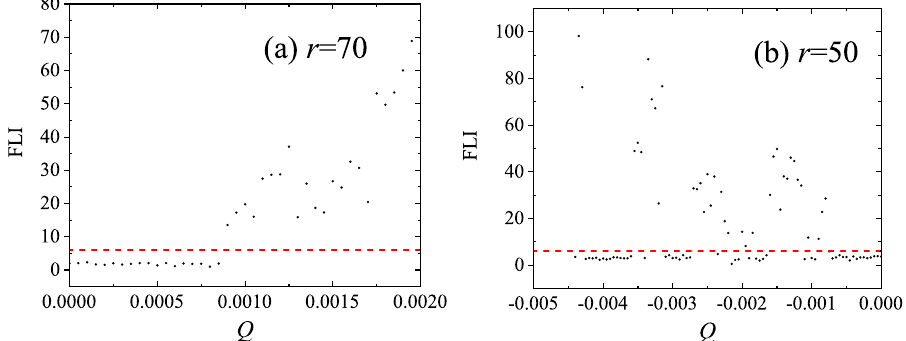
Figure 6. ( a ): Dependence of FLI on the positive magnetic parameter Q in Figure 5a–c. The initial separation is r = 70. The FLI for each value of Q is obtained after the integration time w = 2 × 10 6 . The FLIs ≥ 6 mean chaos, and the FLIs < 6 show the regularity. When Q > 8.5 × 10 − 4 , chaos begins to occur. ( b ): Dependence of FLI on the negative magnetic parameter Q in Figure 5d–f. The initial radius is r = 50. When Q < − 7.5 × 10 − 4 , there is a dynamical transition from order to